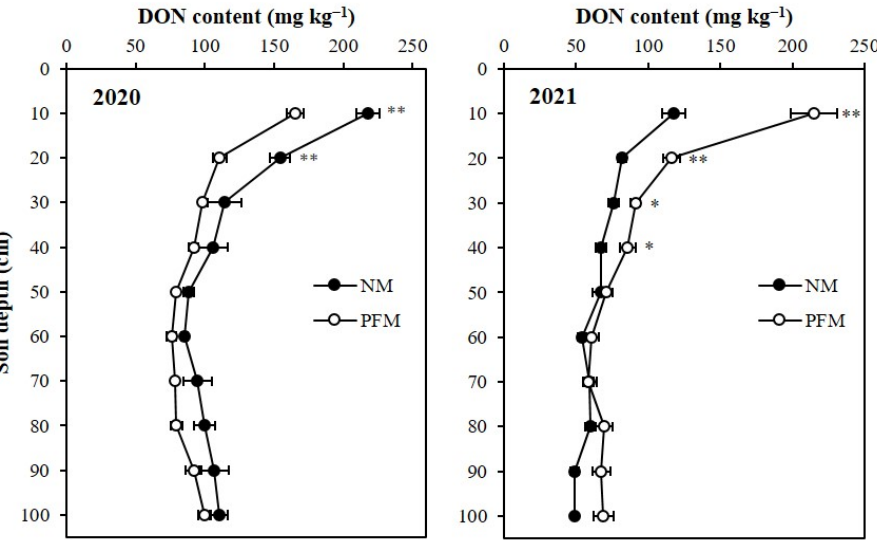
Figure 4. Effects of plastic film mulching and no-mulching treatments on the depth distribution of dissolved organic N (DON) in the soil profile. ** Significant differences between treatments at p < 0.01, * significant differences between treatments at p < 0.05. 2020, soil sampling at final harvest in 2020; 2021, soil sampling at final harvest in 2021. PFM, plastic film mulching; NM, no-mulching (control).